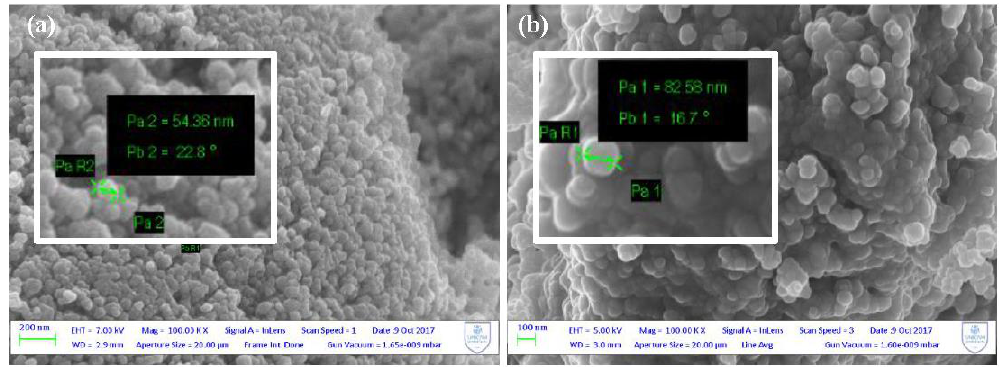
Figure 2. Scanning electron microscope (SEM) micrographs of ( a ) pure [TiO 2 ] A ; ( b ) modified [AA-TiO 2 ] A containing 2.5 wt % of AA.